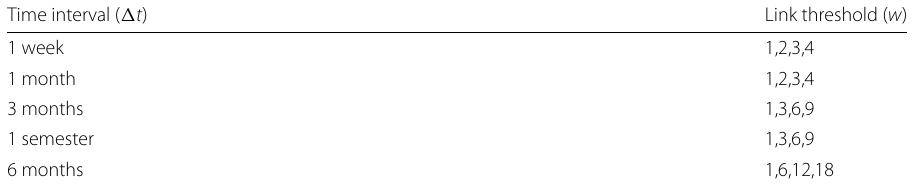
Table 1 Values for time interval length (cid:2) t and edge threshold w that we evaluate in this paper Time interval ( (cid:2) t